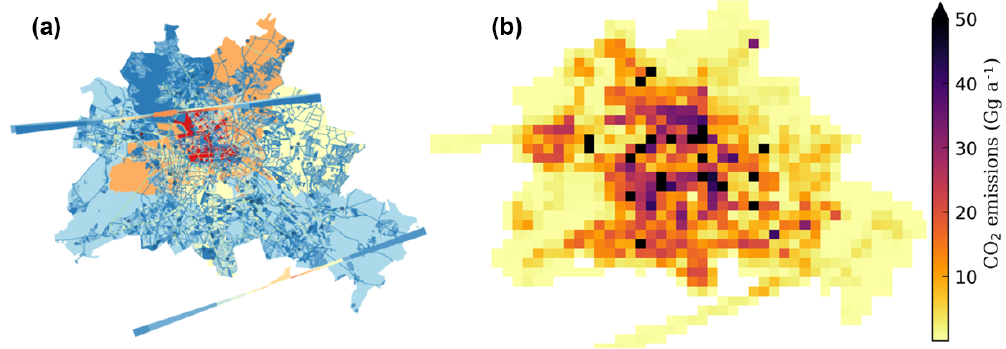
Figure 1. (a) Schematic of CO 2 emissions in the Berlin inventory with point, line and area sources from different emission categories. Point, line and area sources are in different units (in kgs − 1 for point, kgs − 1 m − 1 for line and kgs − 1 m − 2 for area sources) each being colored separately between minimum and maximum values. (b) Total CO 2 emissions re-projected and rasterized onto the COSMO model